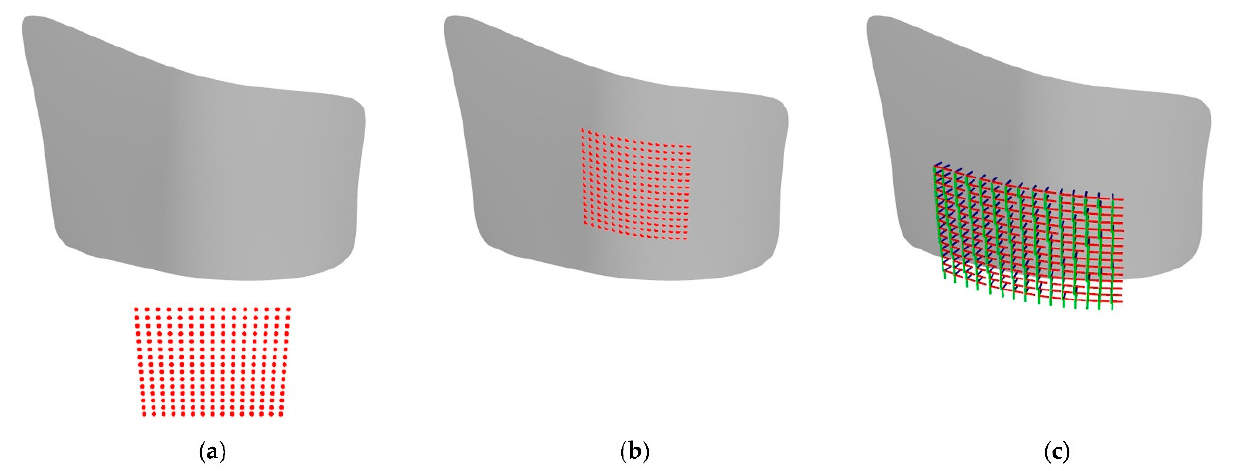
Figure 8. Grid-based waypoint generation. ( a ) Centers of the grid cells; ( b ) projection of grid onto the reconstructed surface; ( c ) 6D waypoints.